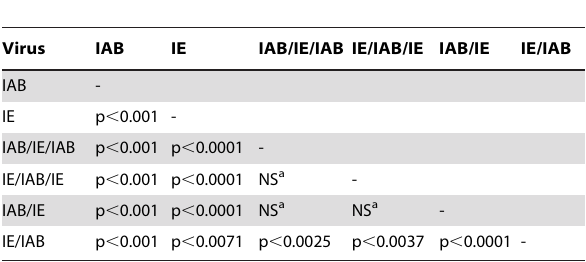
Table 3. Two-tailed Fisher’s exact tests for infection rates of C. taeniopus